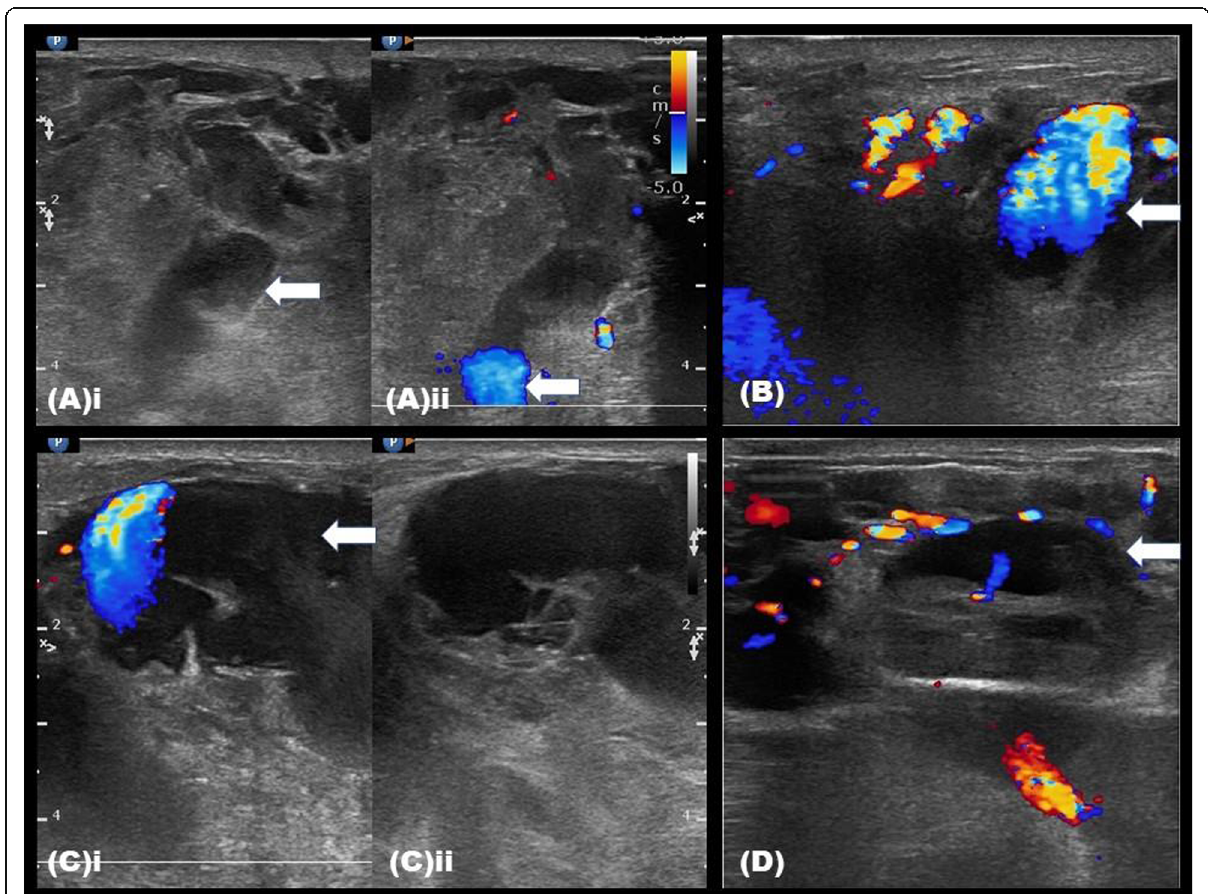
Fig. 1 a – d Ultrasound showed a large irregular mixed echogenic mass with solid and cystic components within seen occupying almost the entire breast. Multiple large vessels with turbulent flow and pulsations were seen within this mass